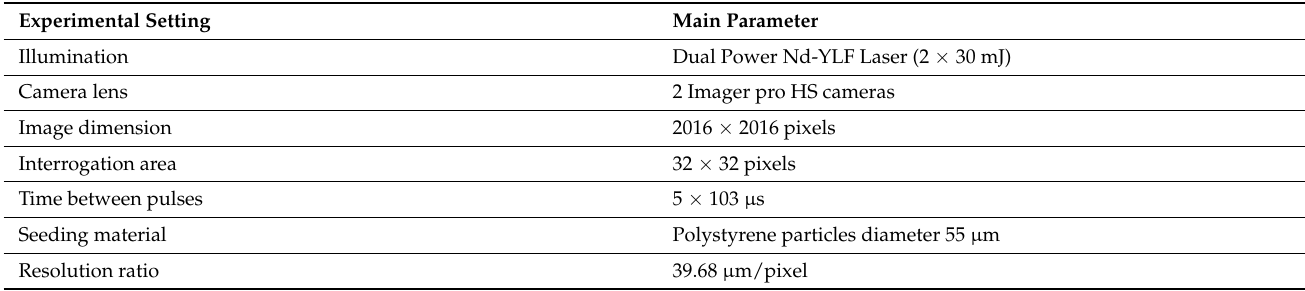
Table 1. Experimental settings for PIV measurements.